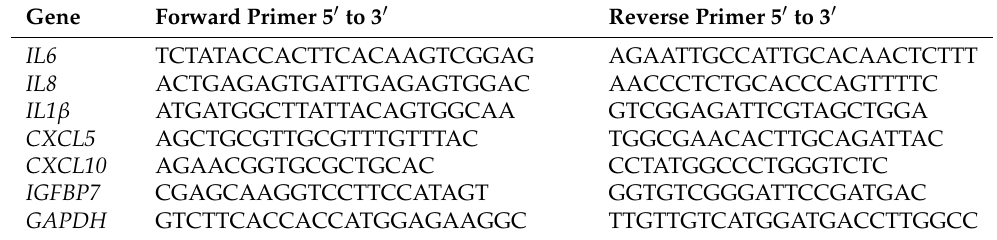
Table 1. Primers for specific human genes.